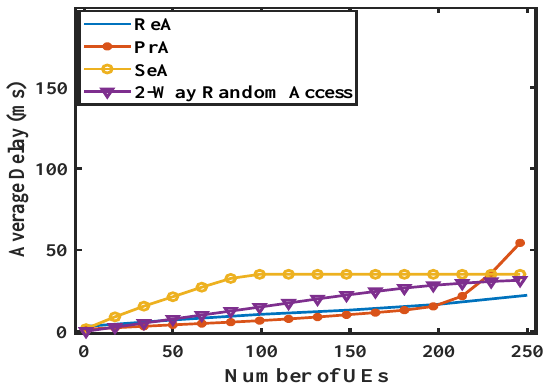
Figure 7. Average delay for random